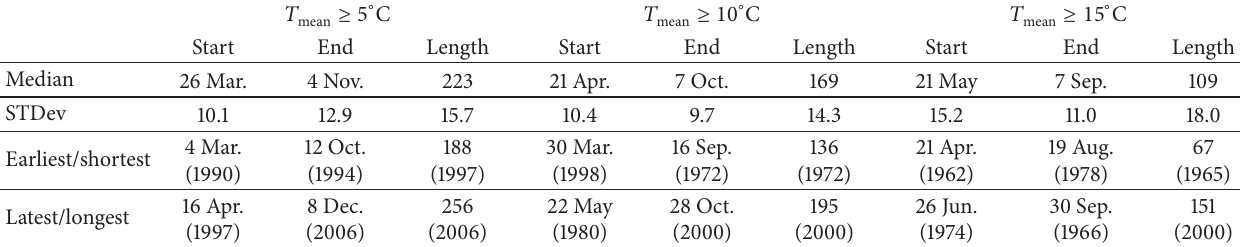
Table 1: Statistical characteristics of the area-averaged growing season parameters of the studied area for